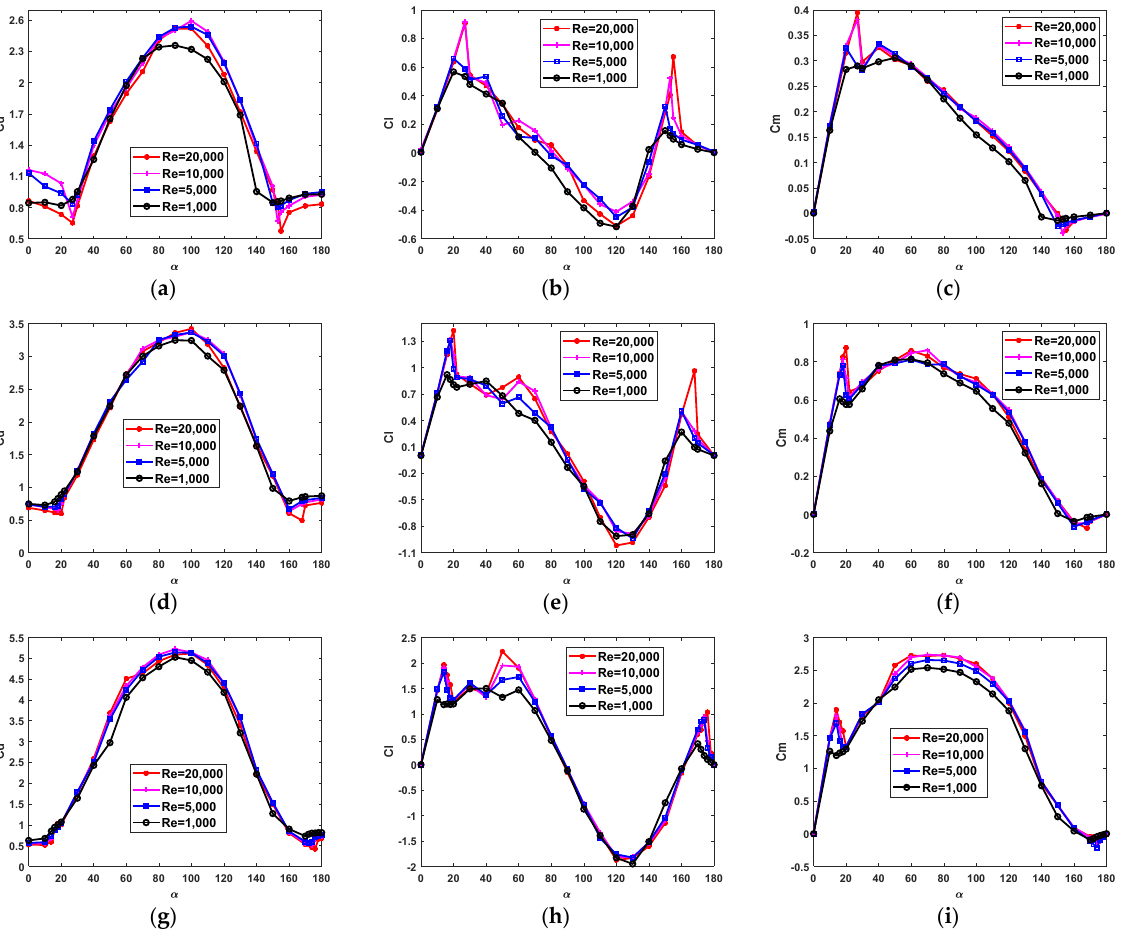
Figure 6. Comparison of the variation of mean aerodynamic coefficients with wind attack angles: ( a ) 0.25D-mean C d , ( b ) 0.25D-mean C l , ( c ) 0.25D-mean C m , ( d ) 0.5D-mean C d , ( e ) 0.5D-mean C l , ( f ) 0.5D-mean C m , ( g ) 1.0D-mean C d , ( h ) 1.0D-mean C l , and ( i ) 1.0D-mean C m .